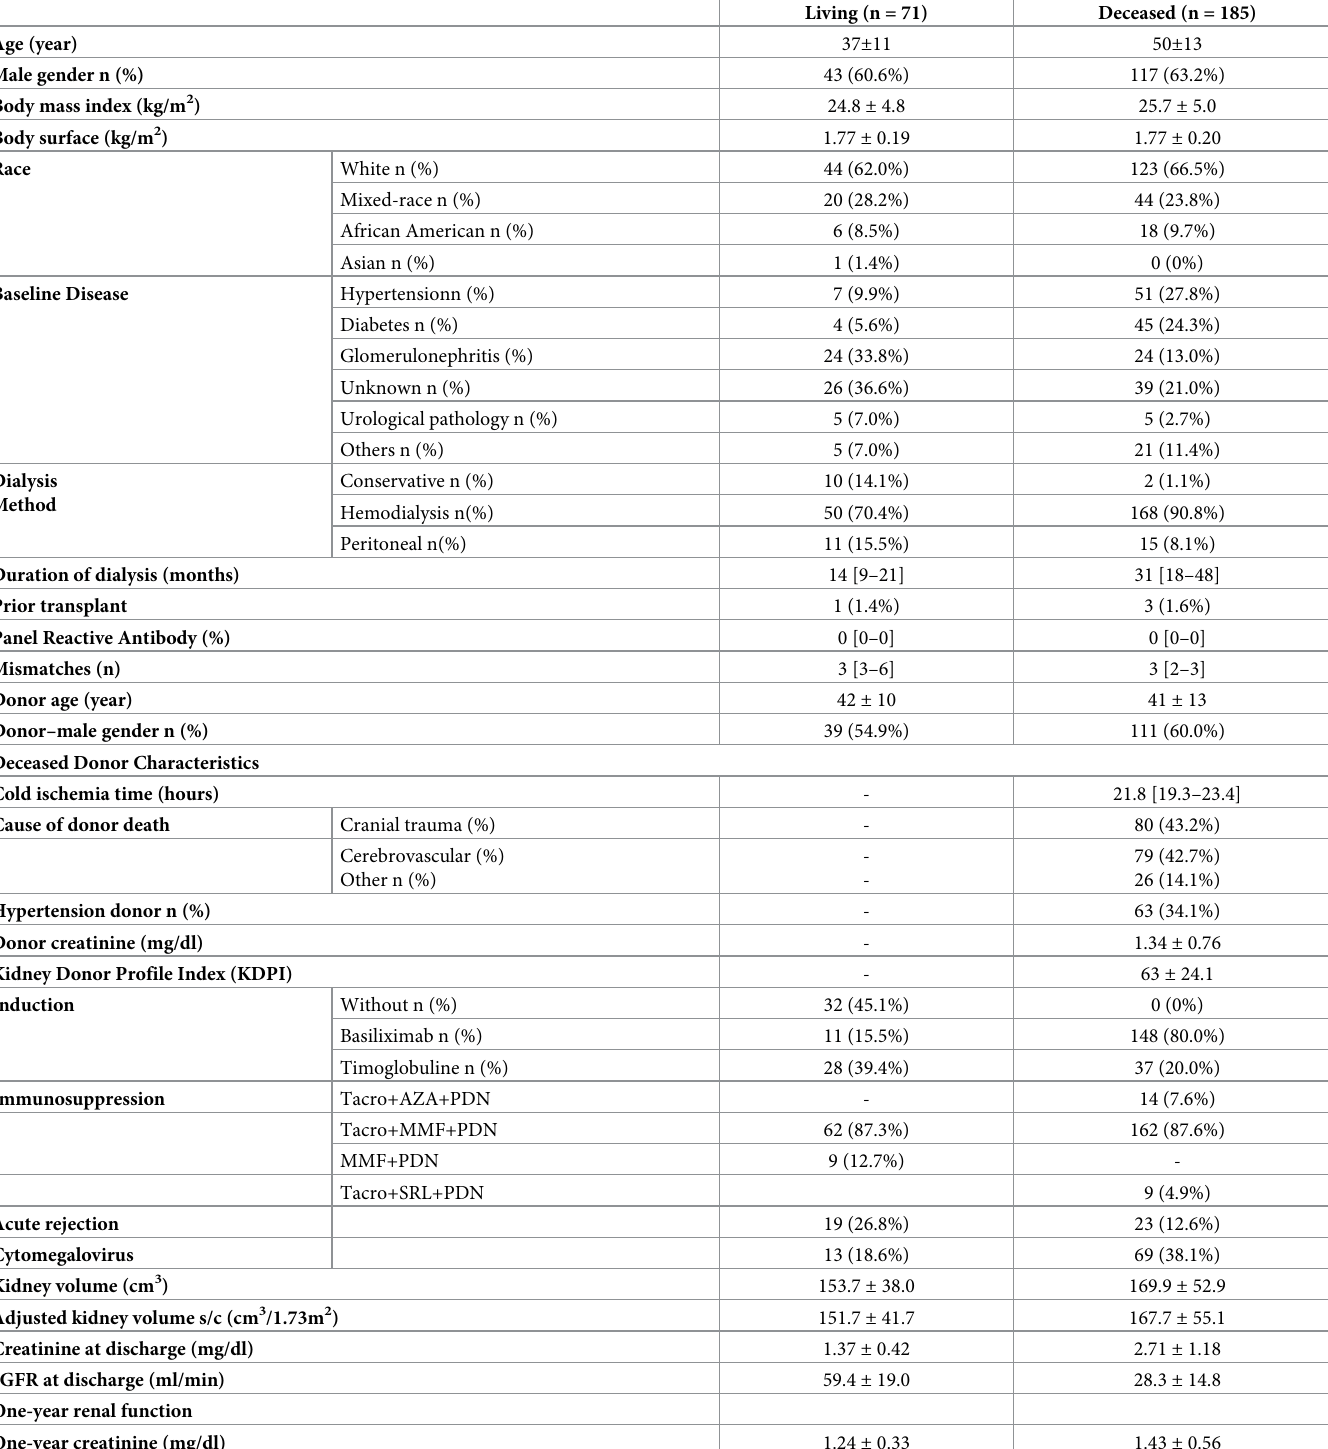
Table 1. Patient characteristics at baseline and after the one-year follow up–the living donor kidney transplantation group (n = 71) and the deceased donor group (n =